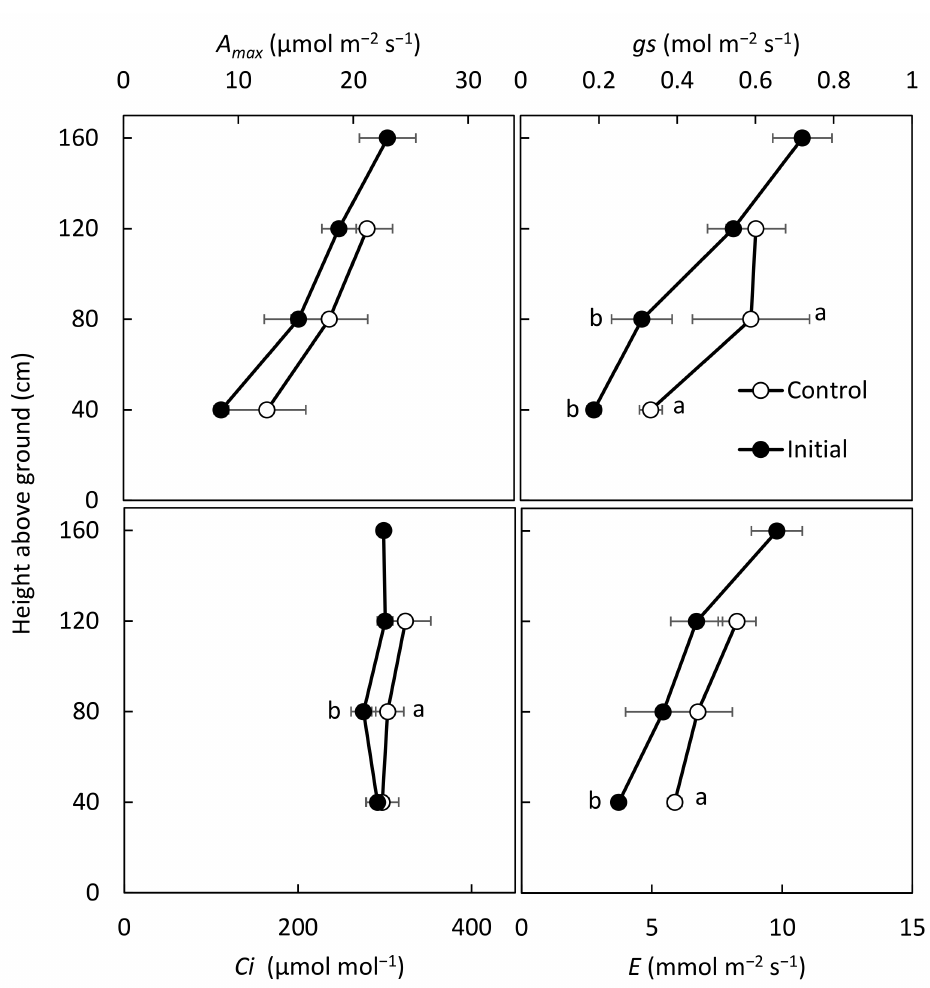
Figure 3. Effect of the control ( ) and initial fertilization treatment ( • ) on maximum photosyn-thetic (cid:35) rate ( A max ), stomatal conductance ( gs ), intercellular CO2 concentration ( Ci ), and transpiration rate ( E ) at different heights of the plant community. Different letters indicate statistical significance at p <